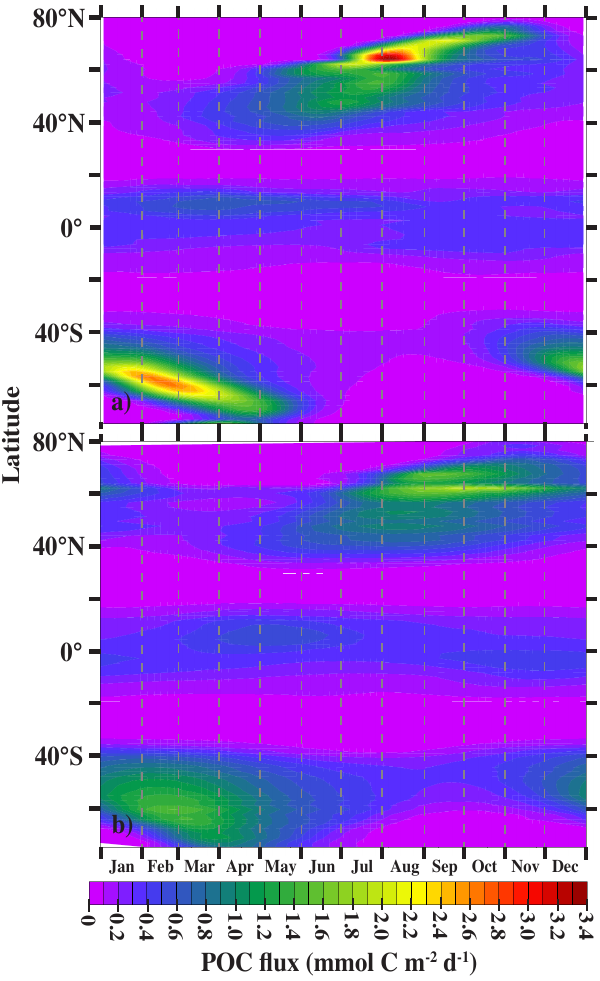
Fig. 22. Hovm¨oller diagrams of the zonally averaged seasonal fluxes of POC at 2km as simulated by the (a) new and (b) old mod- els.